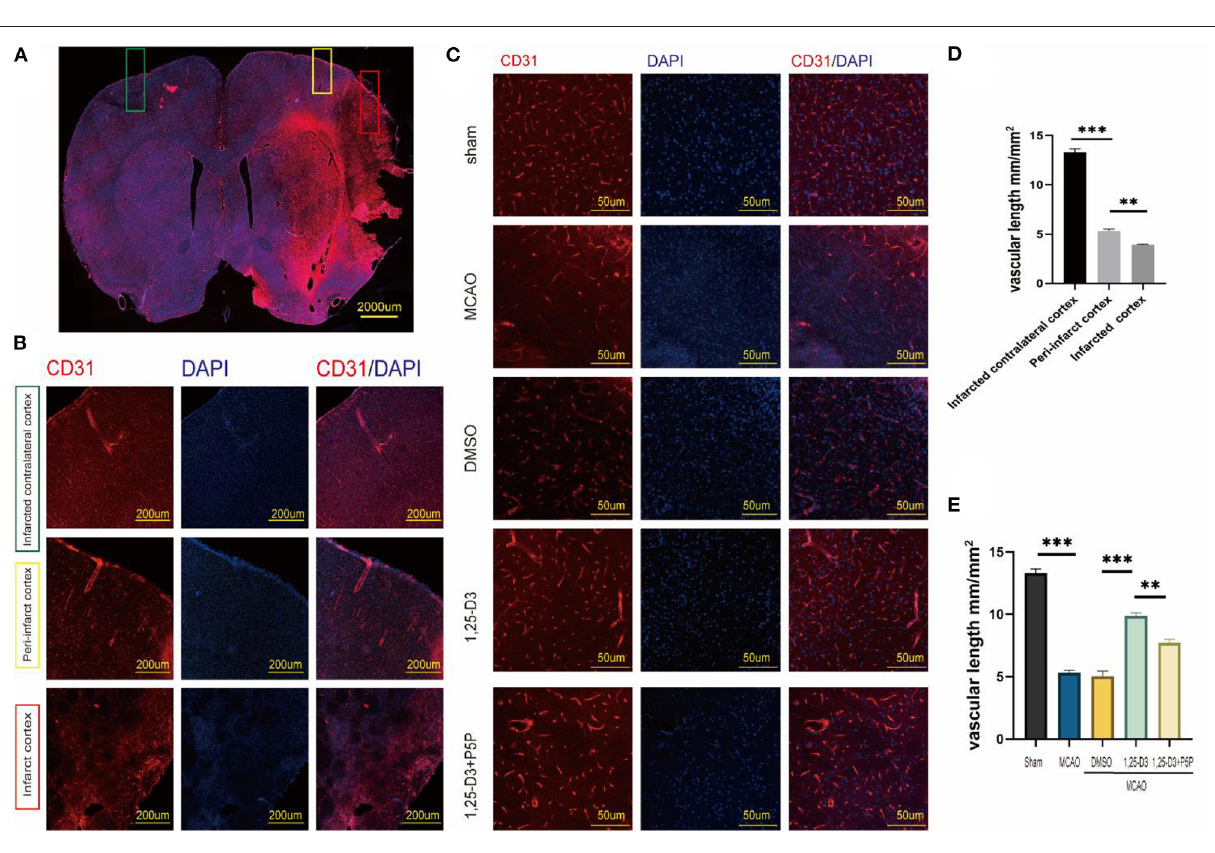
FIGURE 3 | 1,25-D3 increased the microvascular length and density and alleviated impairments induced by cerebral ischemic reperfusion 3 days after MCAO. (A,B,D) In situ expression of CD31 (red) and 4’,6-diamidino-2-phenylindole (DAPI; blue) in different region of MCAO group (100 × magnification 100). (C,E) In situ expression of CD31 (red) and 4’,6-diamidino-2-phenylindole (DAPI; blue) in the peri-infarct region of sham, MCAO, DMSO, 1,25-D3 and 1,25-D3 + P5P groups (400 × magnification 400). Data were represented as Mean ± SEM, n = 5 per group. * p < 0.05, ** p < 0.005, *** p < 0.001. MCAO, middle cerebral artery occlusion; 1,25-D3, 1 α ,25-dihydroxyvitamin